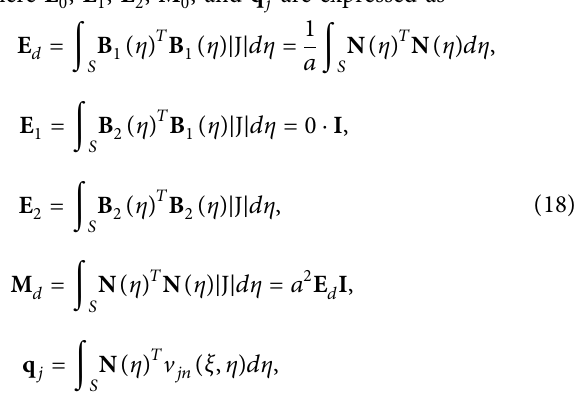
s / ω 0 with respect to σ 0 for � with c 0 0